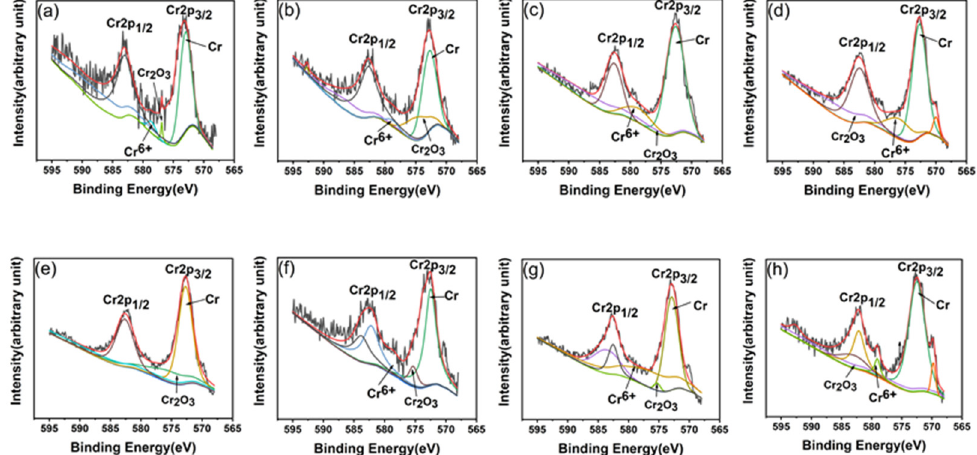
Figure 11. XPS energy spectra of chromium of Z3CN20-09M stainless steel after different amounts of aging: ( a ) 0 h, ( b ) 272 h, ( c ) 544 h, ( d ) 1000 h, ( e ) 3000 h, ( f ) 6000 h, ( g ) 10,000 h, ( h ) 15,000 h.